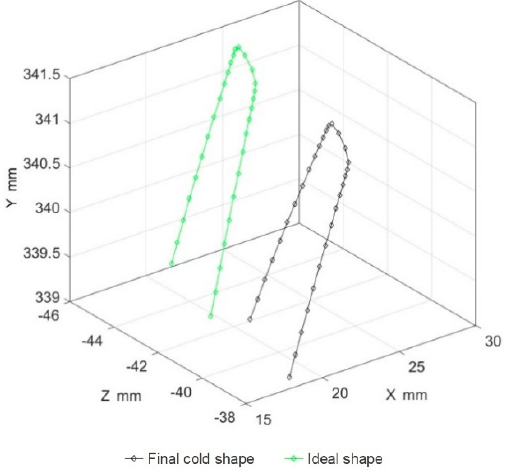
Figure 9. Positions of some contour nodes at the top trailing edge of the cold blade shape.